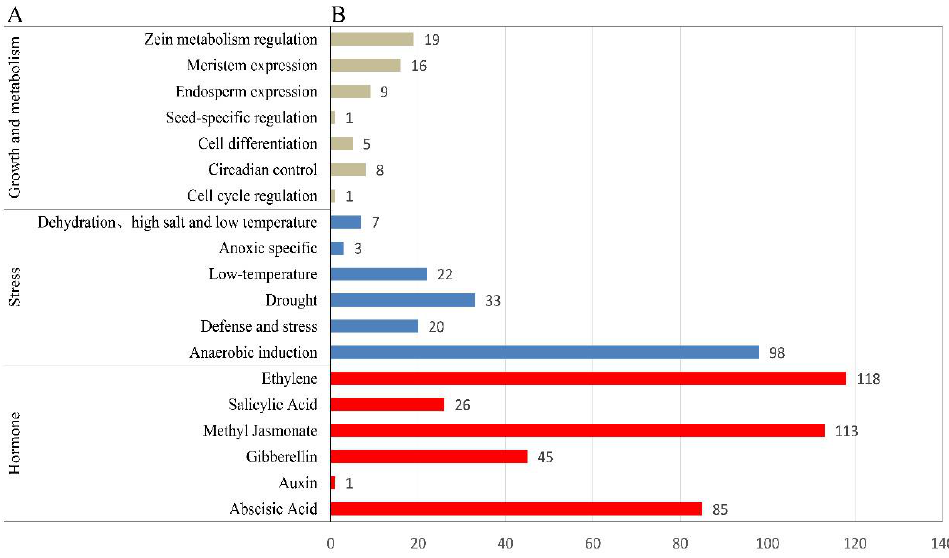
Figure 4. Statistics and classification of the cis-acting elements of PtrFRS s. ( A ) The cis-acting elements in the 1500 bp region upstream of PtrFRS s were divided into three groups according to their function. ( B ) The number of each cis-acting element of PtrFRS s.